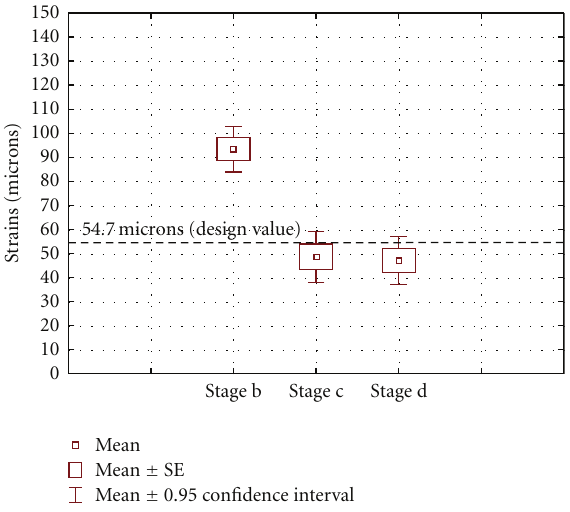
Figure 17: Average strains at the bottom of the AC layers.